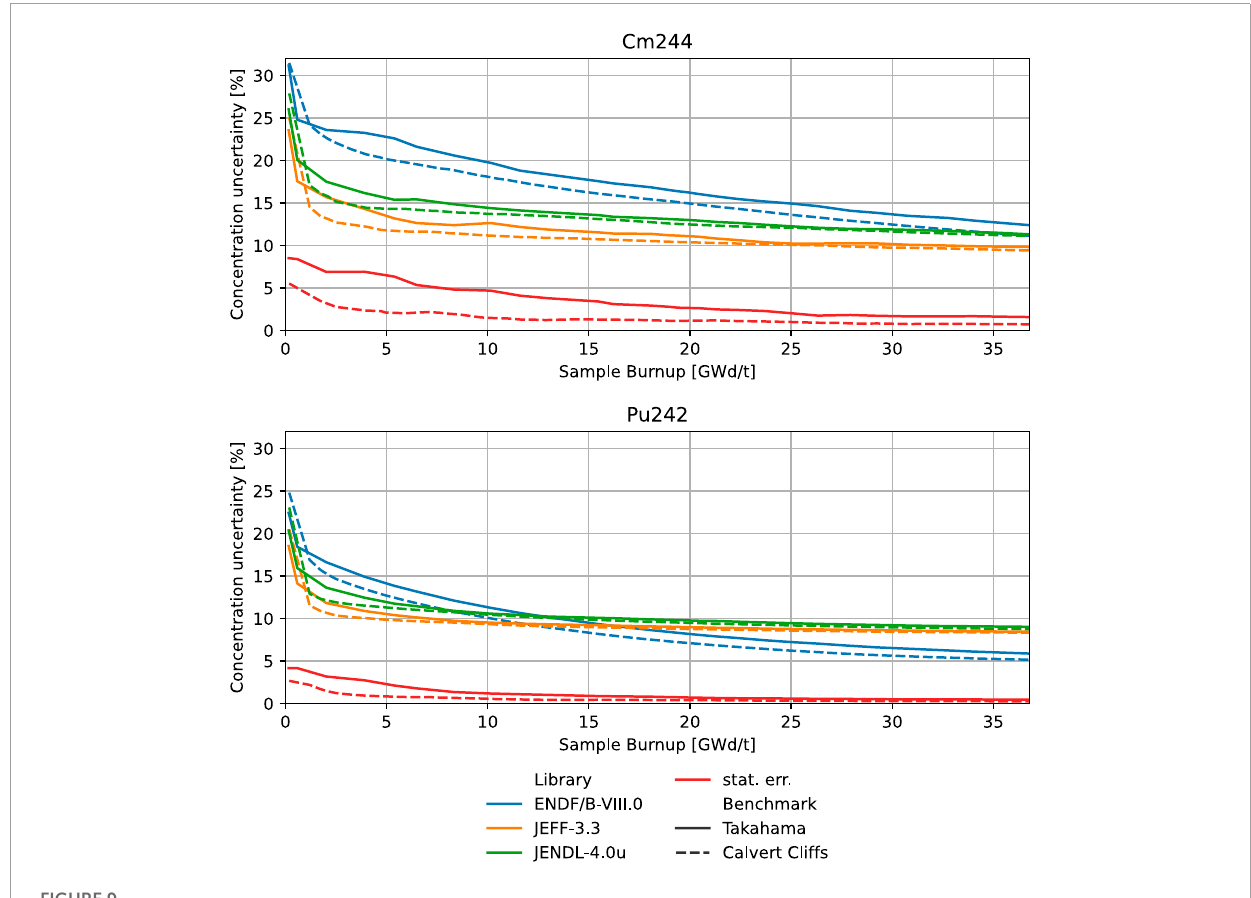
FIGURE 9 Concentration uncertainty evolution with burnup for nuclides 244 Cm (top) and 242 Pu (bottom).